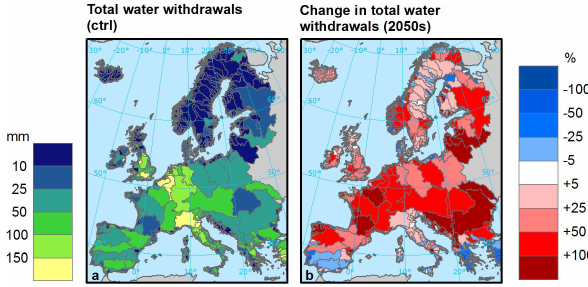
Fig. 7. Total annual water withdrawals aggregated to river basin scale for the control period (a) and the corresponding expected changes in the 2050s according to the EcF scenario from the SCENES project (b) .